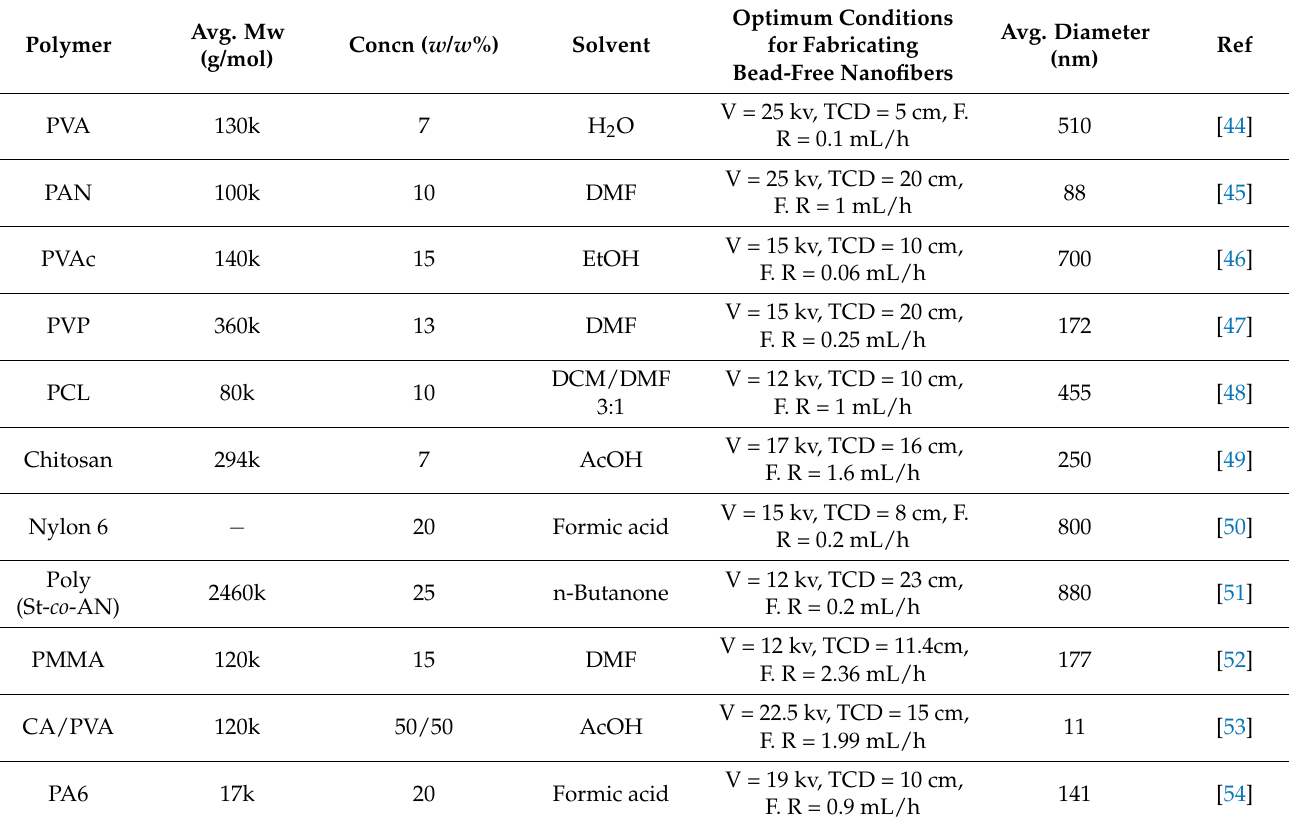
Figure 1. Schematic of types of electrospinning setup and morphology of nanofibers. Table 1. Optimization of electrospinning conditions for fabricating common polymer